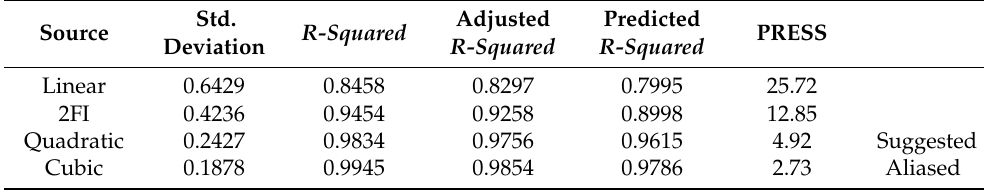
Table 6. Model summary